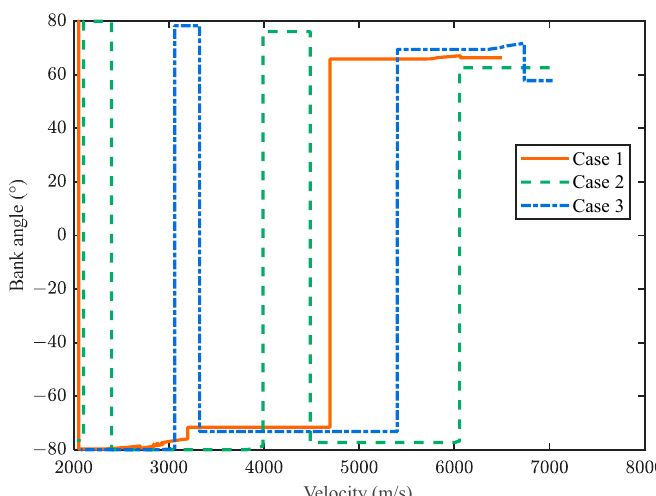
Figure 26. Velocity histories of the bank angle.